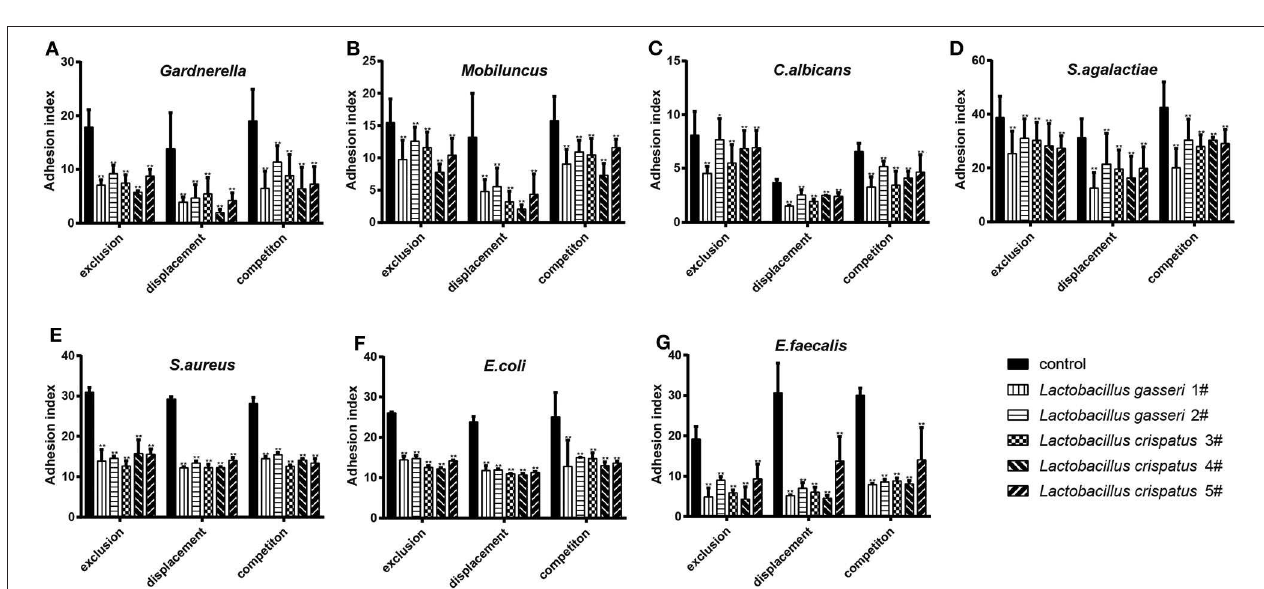
FIGURE 3 | Inhibitory effects of the five Lactobacillus strains on the adhesion of seven pathogenic strains to the VK2/E6E7 VECs. (A–G) The adhesion indexes of each pathogen in the control and experimental groups are shown. The control group shows the adhesion indexes of the pathogens when their adhesion was not inhibited by Lactobacillus (1#, 2#, 3#, 4#, and 5#), whereas the experimental groups show the adhesion indexes of each pathogen after the exclusion, displacement, and competition effects of Lactobacillus antagonization. Adhesion index, adhering pathogen/cell number. The adhering pathogen number is the total quantity of pathogens adherent to 50 intact VECs, which were selected at random. These intact VECs were observed, and the pathogen number was counted using a light microscope at 1000 × magnification under oil immersion. Each adhesion index value is shown as the mean ± SD. Student’s t -test was performed. * P < 0.05; ** P < 0.001; the difference in the adhesion indexes of the pathogens in the control and experimental groups was statistically significant.